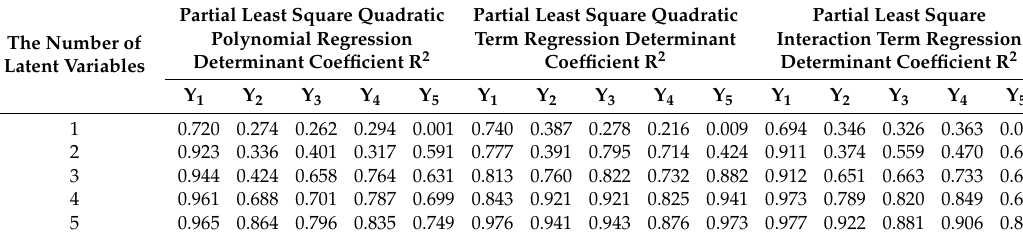
Table 6. The number of latent variables versus the determinant